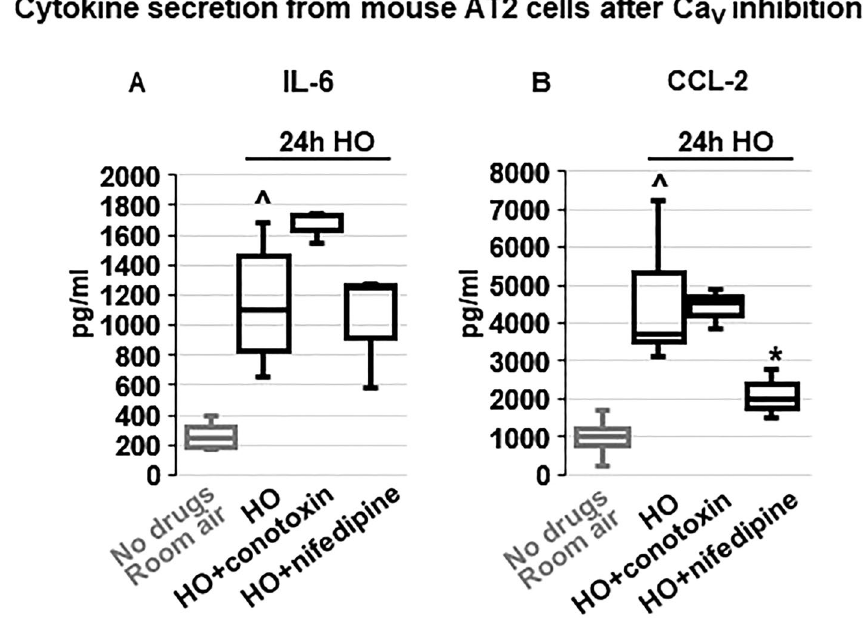
Figure 8. Effects of voltage-gated Ca 2+ channel (Ca V ) inhibition on cytokine secretion from primary mouse AT2 cells: HO exposure increased IL-6 ( A ) and CCL-2 ( B ) secretion compared to RA-treated cells. Inhibition of N- and P/Q-type Ca V channels with ω-conotoxin MVIIC or L-type Ca V channels with nifedipine revealed that IL-6 secretion occurred independently of Ca V channel activity, whereas CCL-2 secretion was dependent on L-type Ca V channels (inhibited by nifedipine) but not N- and P/Q-type channels (lack of ω-conotoxin MVIIC effect). Data are represented as Box-Whisker plots with medians, 1st and 3rd quartiles, and max and min values; n = 3–6; ^compared to cells treated with a vehicle control and exposed to room air (No drugs), *compared to HO exposed cells; p ≤